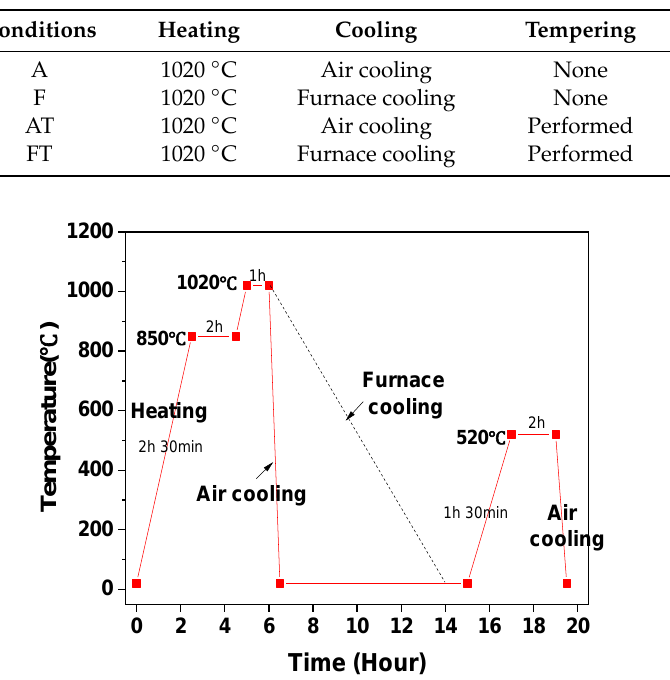
Figure 3. Graph of post-heat treatment temperature.